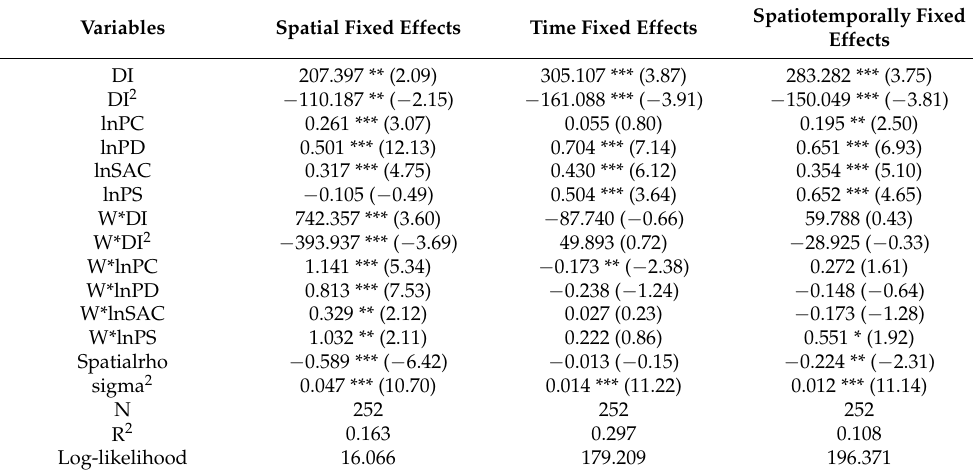
Table 5. Regression results of the SDM with different fixed effects.